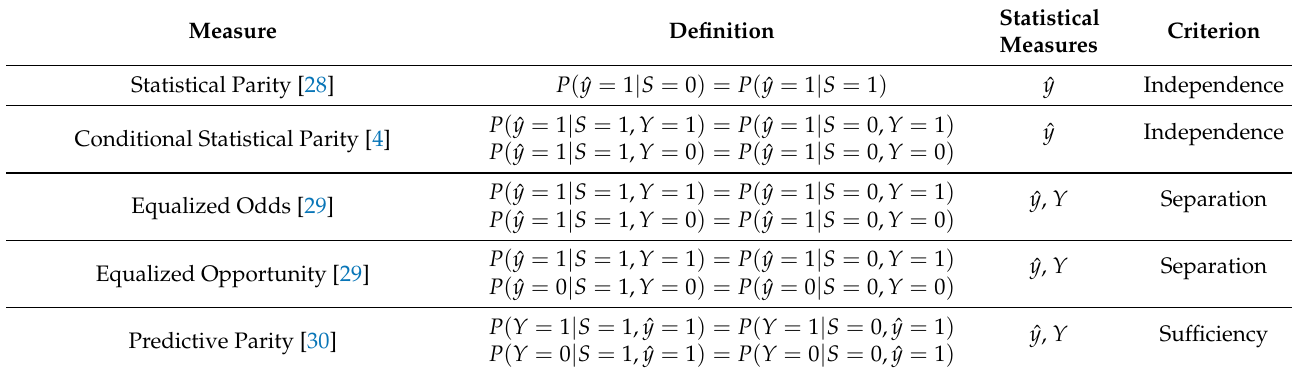
Table 1. Definitions of Group Fairness (adapted from [17,18,20]).